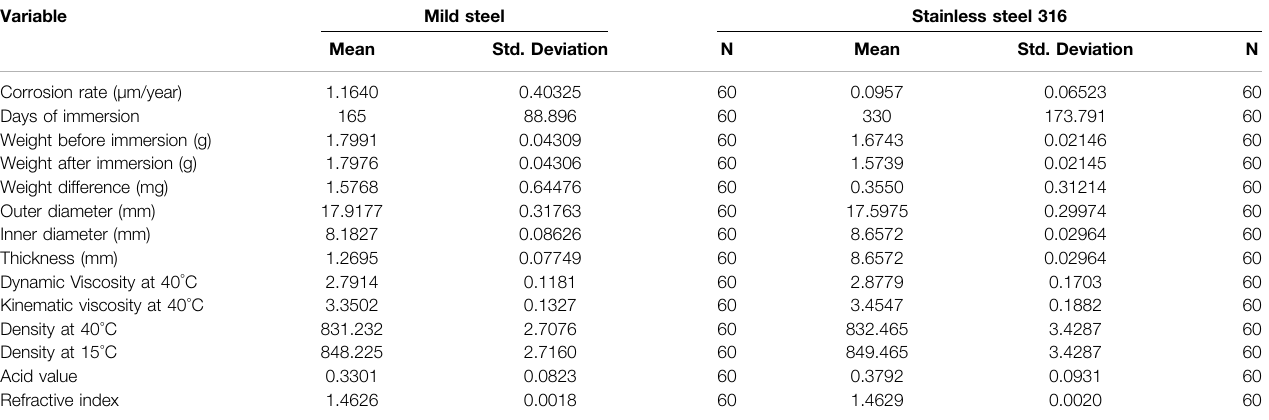
TABLE 6 | Descriptive statistics for mild steel and stainless steel 316.